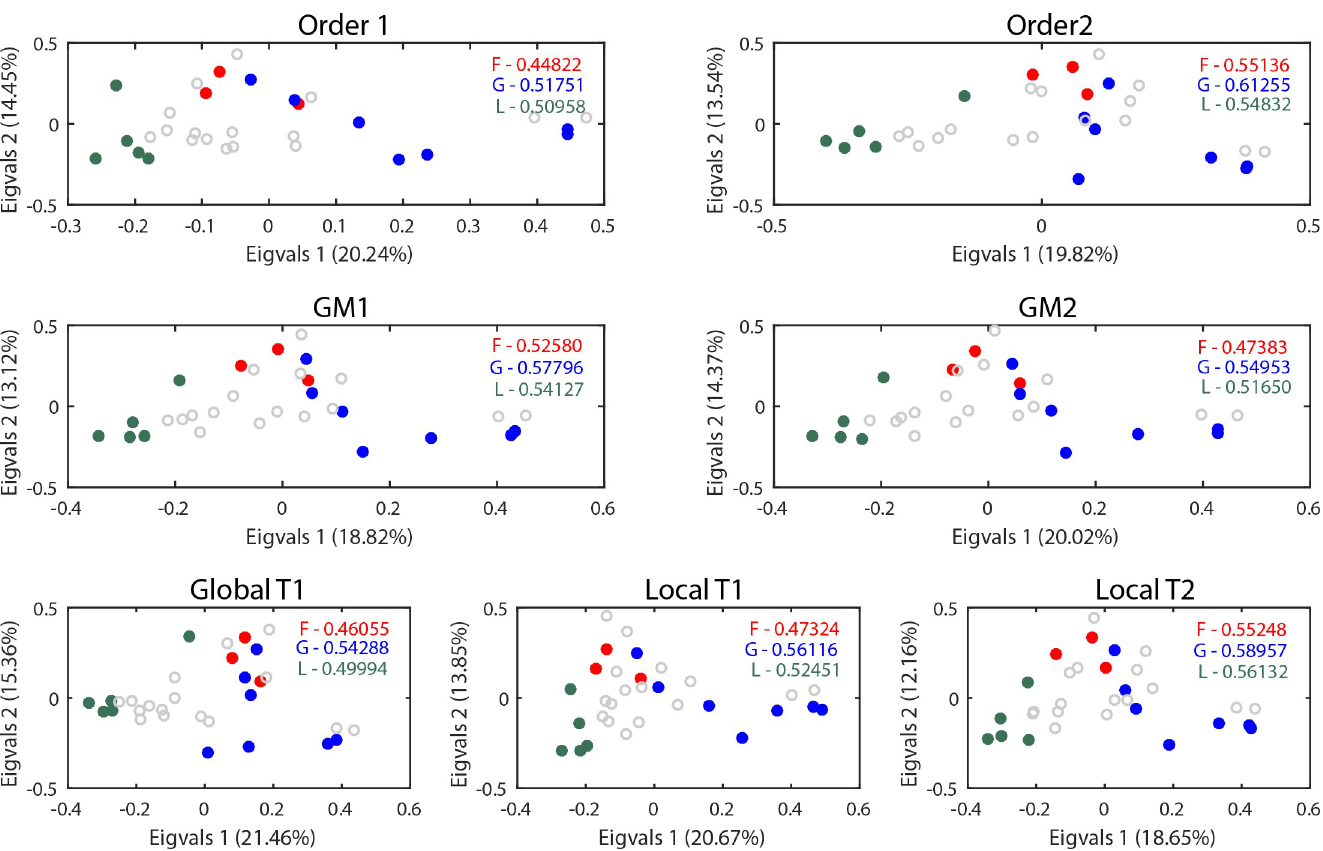
Fig 3. Influence of preprocessing decisions on capturing tissue similarities. Visual representation using a Principal Coordinates Analysis of the similarity between tissues grouped by organ system for each preprocessing decision (numbers in legends are the mean Euclidean distance of the tissues belonging to each group; F– Female reproductive group, G–Gastrointestinal group, and L–Lymphatic